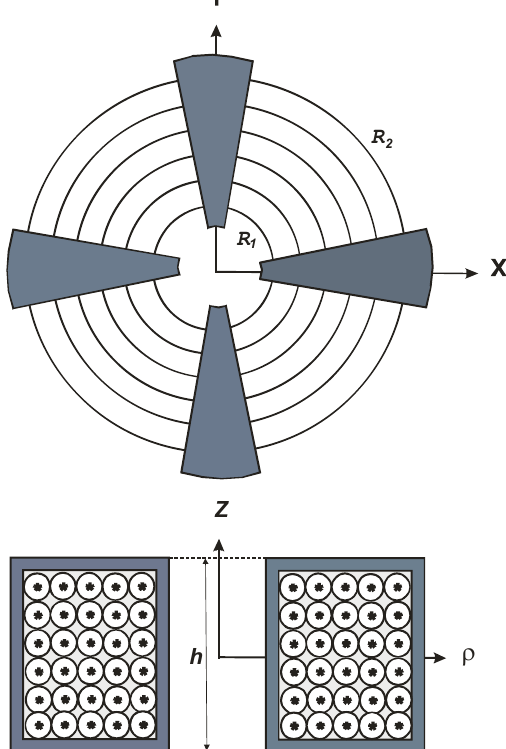
Fig. 1. Top view of the coil with screens in the form of brackets (top part of the picture) and the cross-section of the coil through the screen (low